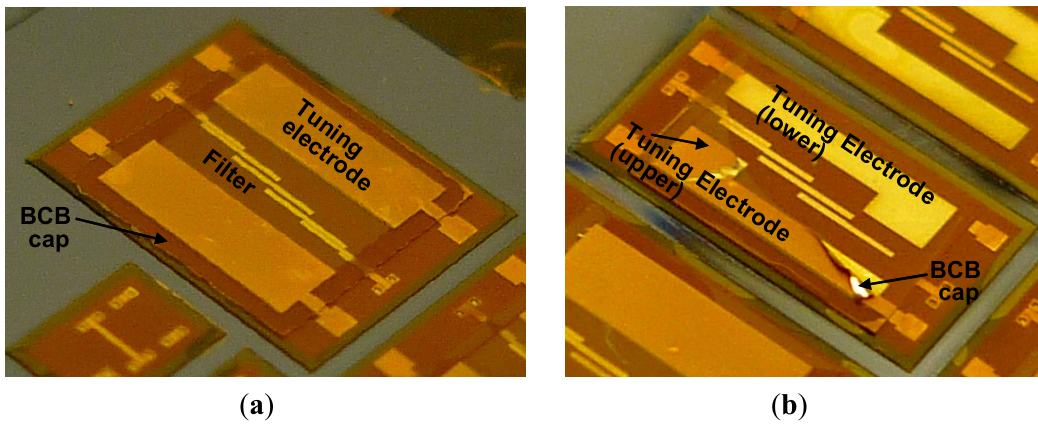
Figure 6. Fabricated tunable